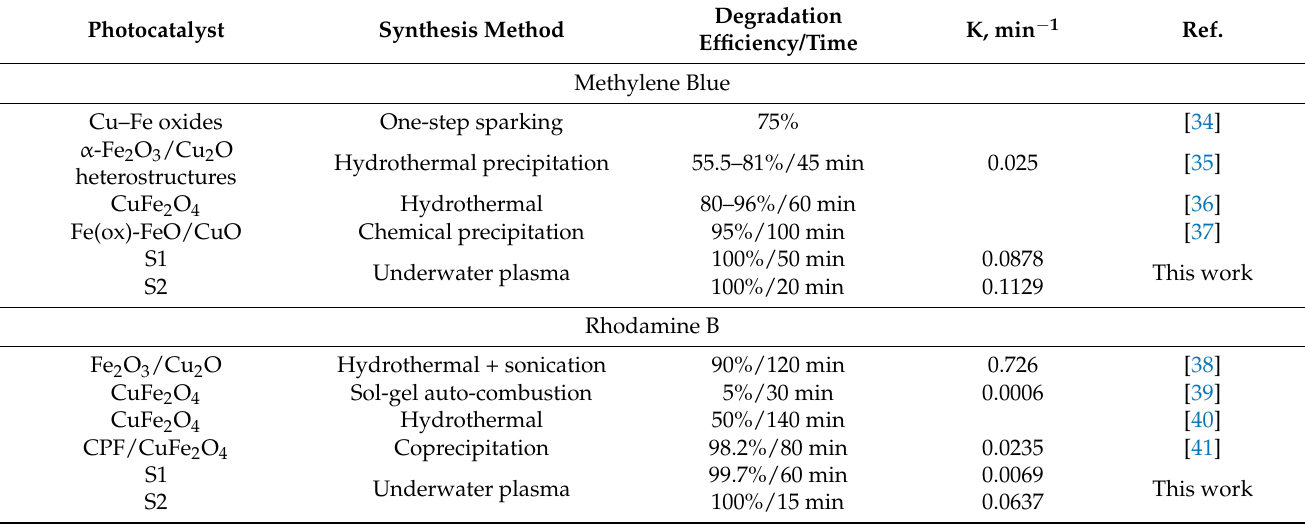
Table 8. Summary of some previously published data in the photocatalytic activity of Cu–Fe binary